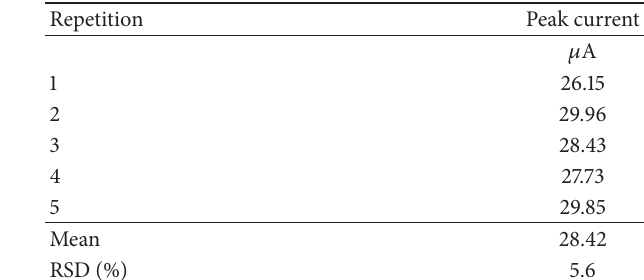
Table 1: Repeatability study for the determination of paracetamol at SWCNT/Ni-modified electrodes.